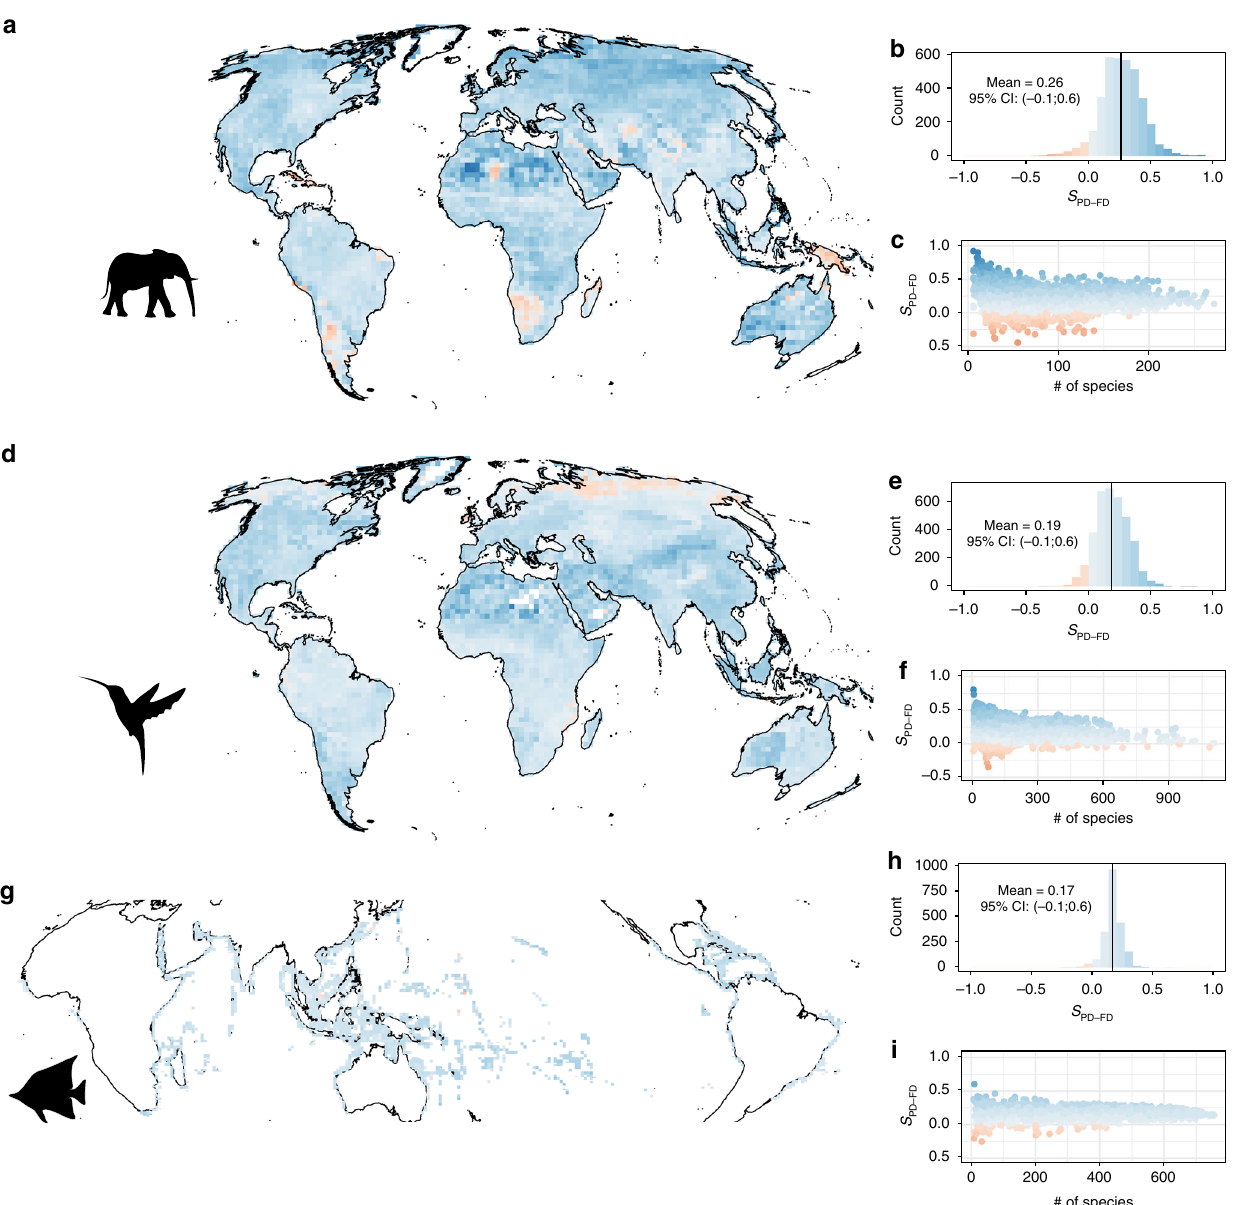
Fig. 2 PD is a good surrogate for FD across geographical areas. The fi gure presents the distribution and correlates of S PD – FD for mammals ( a – c ), birds ( d – f ), and tropical fi shes ( g – i ) separately across space. For each of the three groups, the S PD – FD frequency distribution is presented in top panels ( b , e , h ) along with its mean (vertical line). The color scheme is common to all panels, with blue indicating positive S PD-FD (maximizing PD captures more FD than random) and red indicating negative S PD – FD . S PD – FD geographical distribution is presented in middle panels ( a , d , g ). Relationships between S PD – FD and species pool richness are presented in panels c , f , i . In each grid cell, S PD – FD values are based on the mean over 1000 repetitions of random and PDmax set draw (there is only one maxFD set). The maps in this fi gure were generated making use of the R-package rasterVis and latticeExtra. The animal